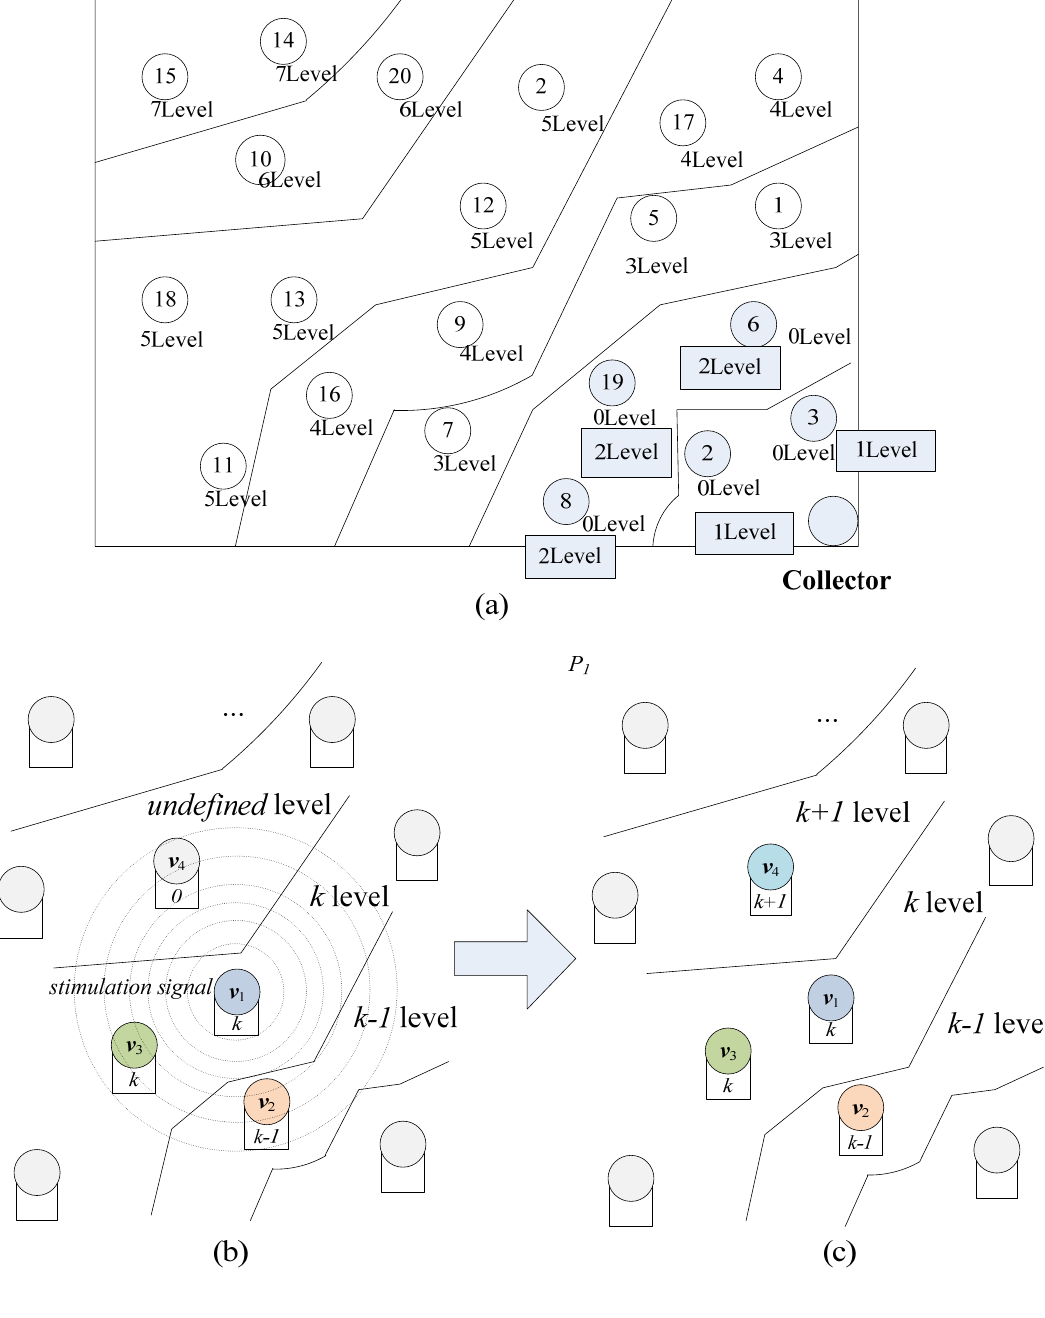
Figure 8. The principle of extended “node level” construction